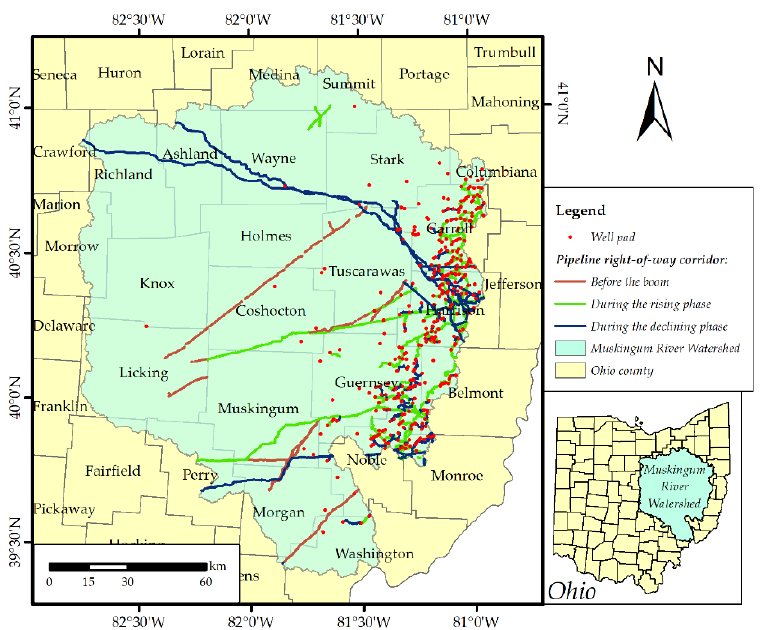
Figure 6. The distribution of the unconventional shale gas extraction activities in the Muskingum River Watersheds.